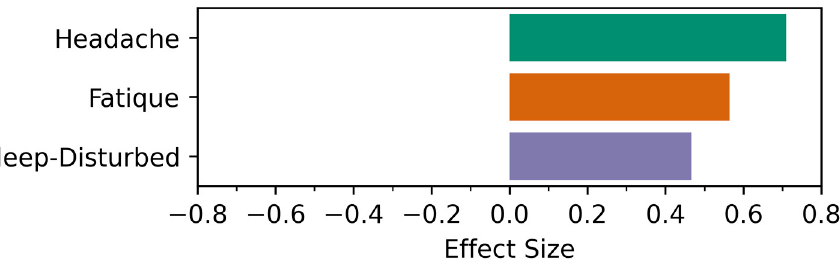
Figure 9. The effect size for the Wilcoxon signed ‐ rank test between the intervention and control period for symptom ‐ frequency ‐ based biomarkers after the first or second vaccination.